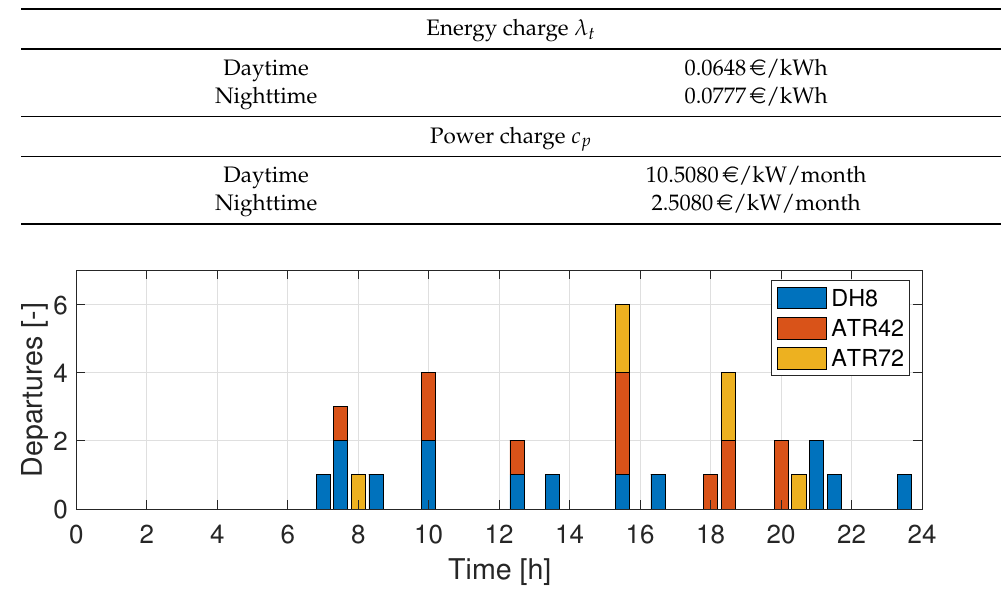
Figure 10. Departure schedule at LGAV for the average day